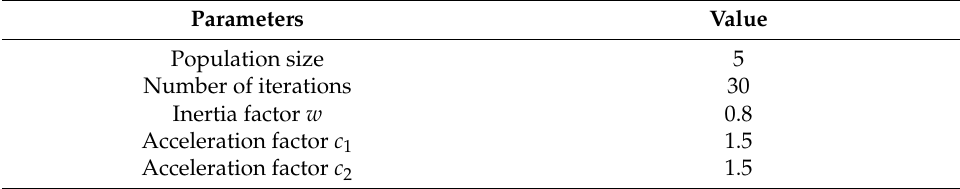
Table 4. PSO-LSTM optimization parameters.